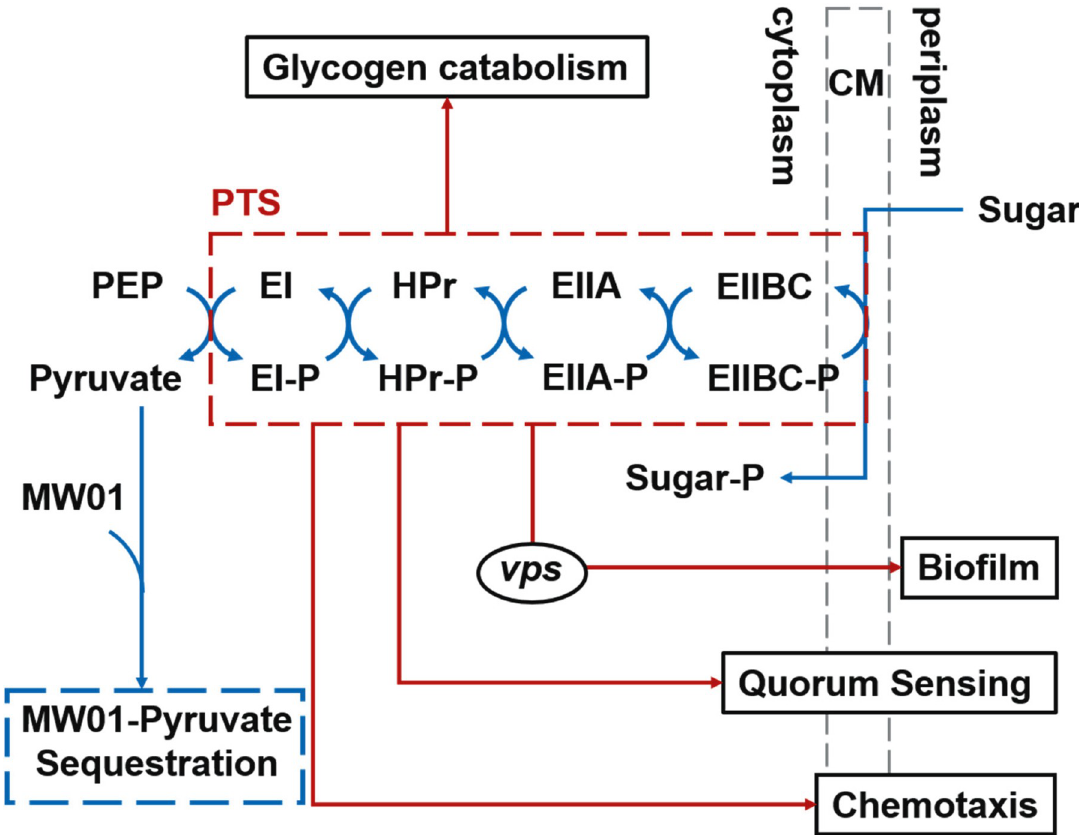
Fig 9. Schematic diagram of the PTS cascade. MW01 interaction with pyruvate, upstream of the phosphor-transferase cascade, would likely impact the regulation of Vibrio biofilm formation and other bacterial regulatory networks through variation of the PEP:pyruvate ratio and modification of the phosphorylation state of the PTS enzymes. This hypothetical scenario however does not preclude the possibility of the pyruvate-MW01 complex forming in media solution and inducing biofilm formation through yet undetermined interactions with Vibrio